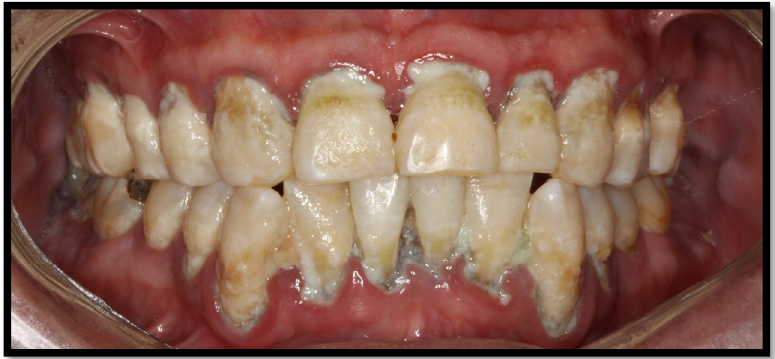
Figure 6. Anterior sextant necrotizing ulcerative periodontitis.